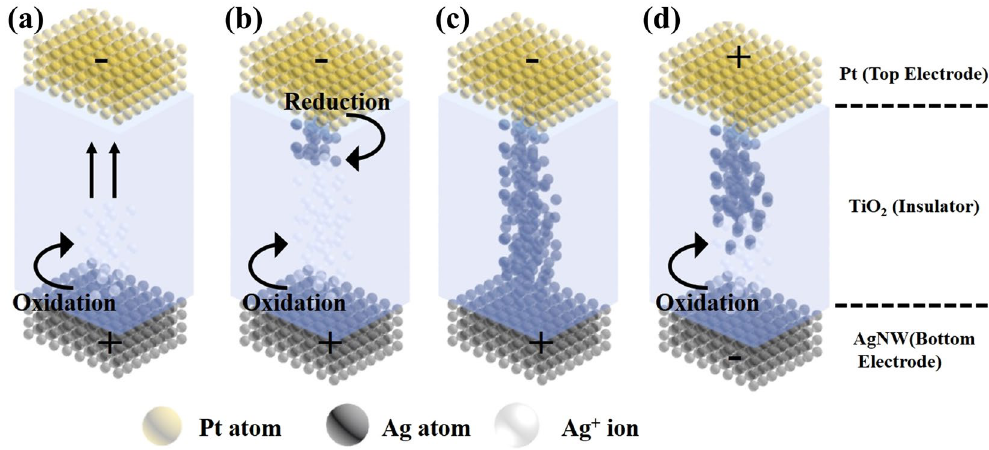
Figure 6. Schematics of the resistive switching process in the FT-RRAM